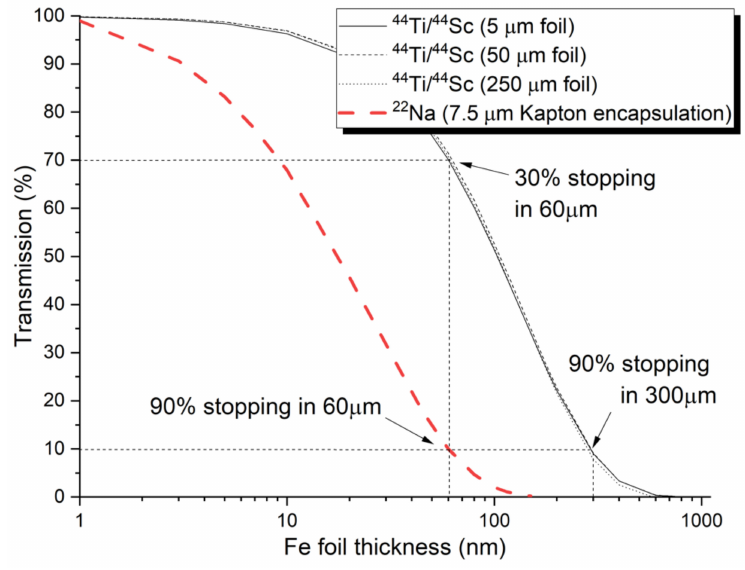
Figure 2. Stopping profile of positrons emitted from a 22 Na Kapton-encapsulated source (thick dashed line) and from 44 Ti/ 44 Sc foil sources of different thicknesses (thin